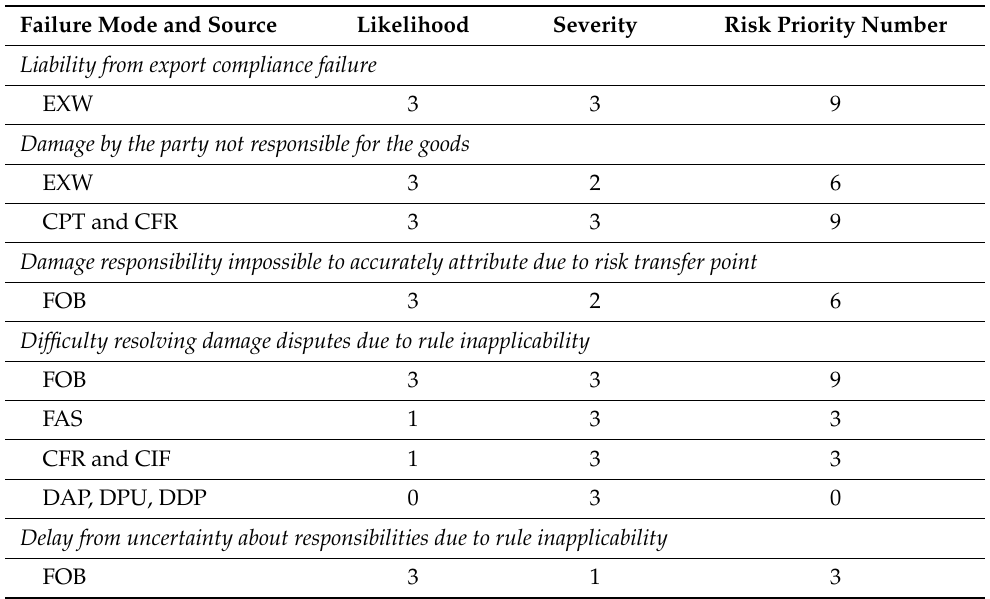
Table 2. Proposed Failure Mode and Effect